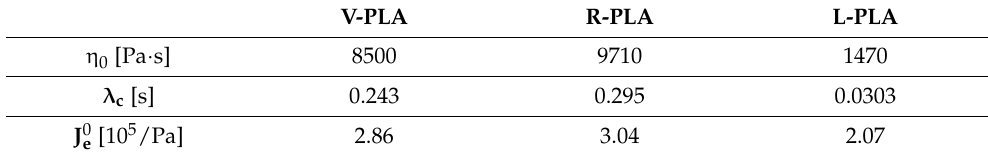
V-PLA R-PLA L-PLA · s] 8500 9710 1470 η 0 [Pa λ c [s] 0.243 0.295 0.0303 J 0 e [10 5 /Pa] 2.86 3.04 2.07